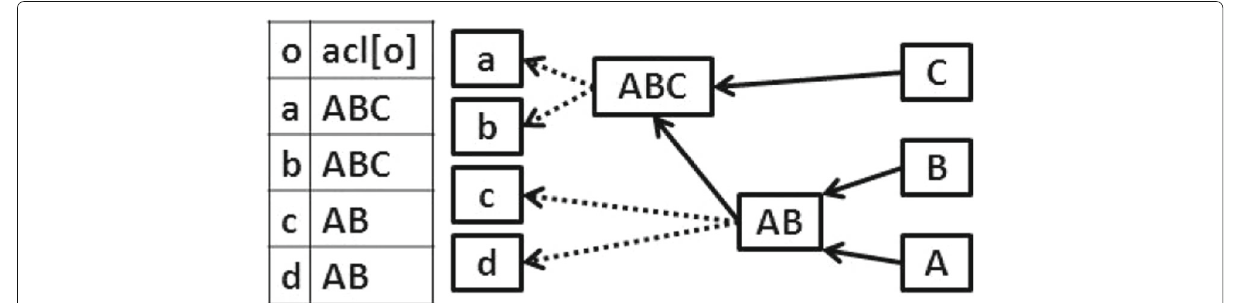
Fig. 10 Modified example of minimal vertex user hierarchy after revoking user D